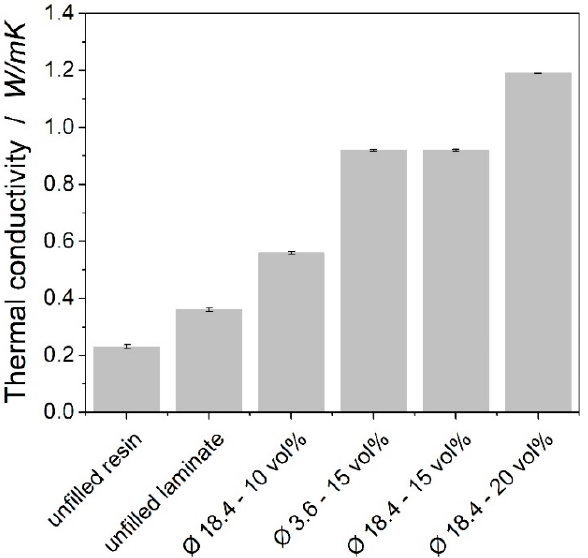
Figure 7. Thermal conductivity of prepreg laminates measured by LFA.